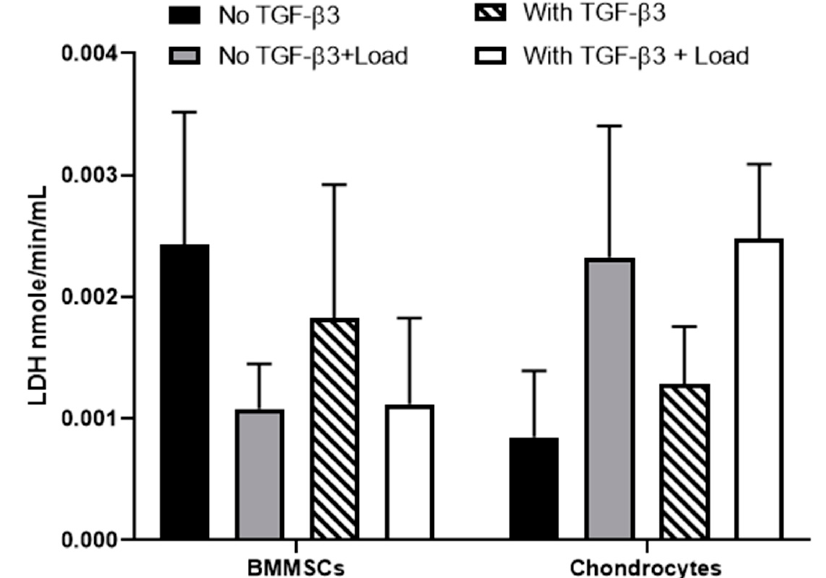
Figure 6. The viability of BMMSCs and chondrocytes encapsulated into the CS-Tyr/Gel hydrogel. The level of secreted lactate dehydrogenase (LDH) measured using ELISA, after the chondrogenic differentiation for 21 days with/without mechanical load for 7 days. The cells were cultivated in chondrogenic medium with or without TGF β 3 and mechanical load. Data are shown as mean ± SD, n = 3 from not less than three different cell cultures of each type.